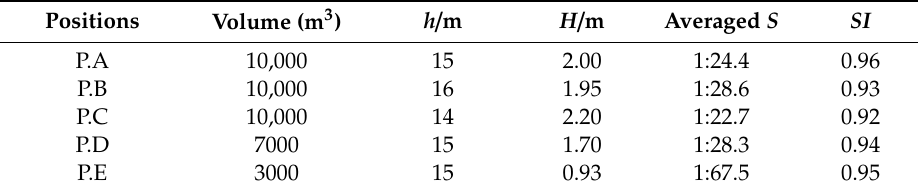
Table 3. Morphological parameters of the mound at five positions.